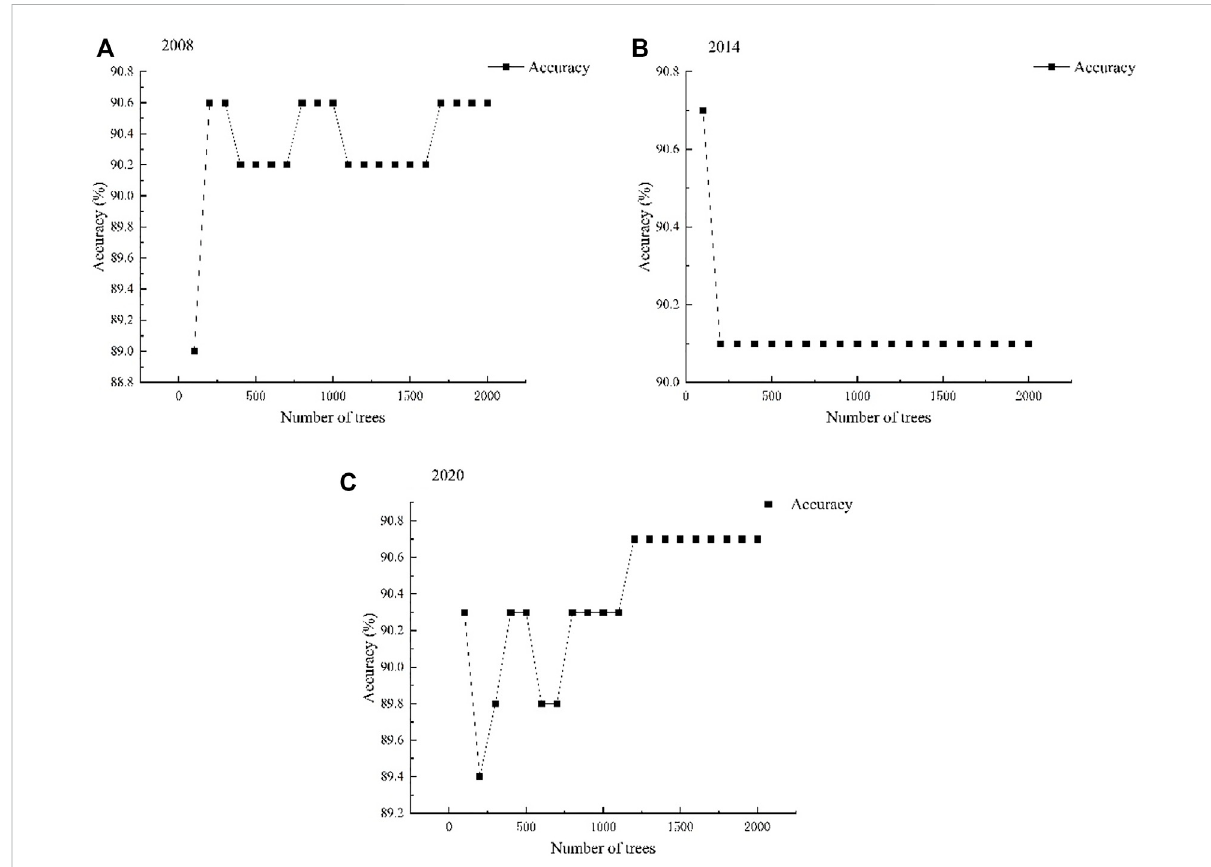
FIGURE 7 The effect of the number of decision trees on classi fi cation accuracy. (A) 2008; (B) 2014; (C)